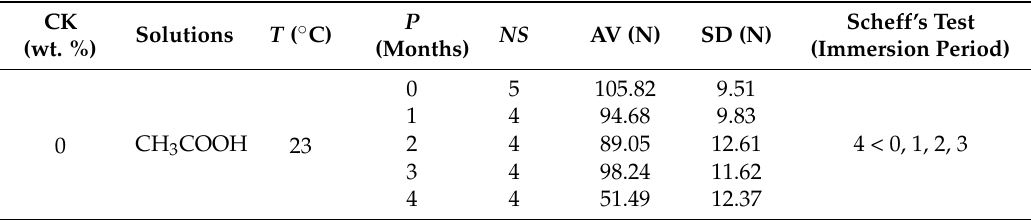
that are immersed in CH 3 COOH, in relation to different immersion